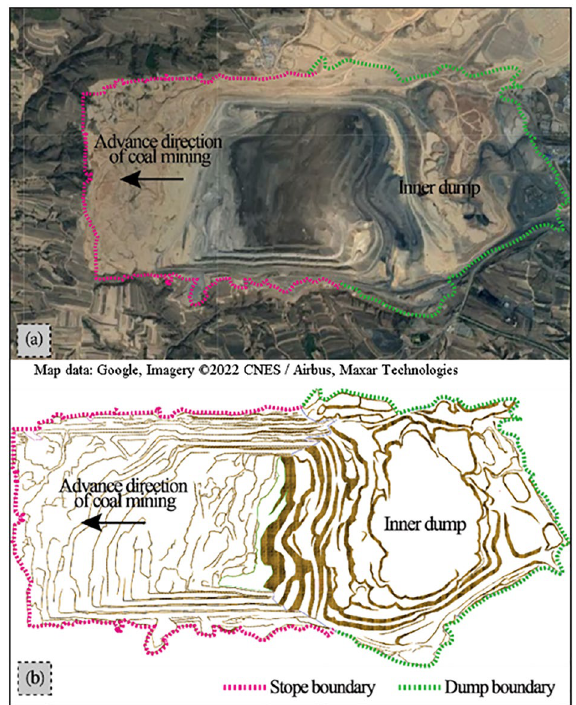
Figure 1. Location of the study area and Geomorphology of the open pit mine: ( a ) Aerial view of the Pingshuo East-Open pit mine (Satellite image source from Google Earth); ( b ) Open pit mine production status model diagram (3DMine Mining Engineering Software Version 11.6). The range circled in red is the stope boundary, and the range circled in green is the dump boundary. Arrows indicate the advance direction of coal